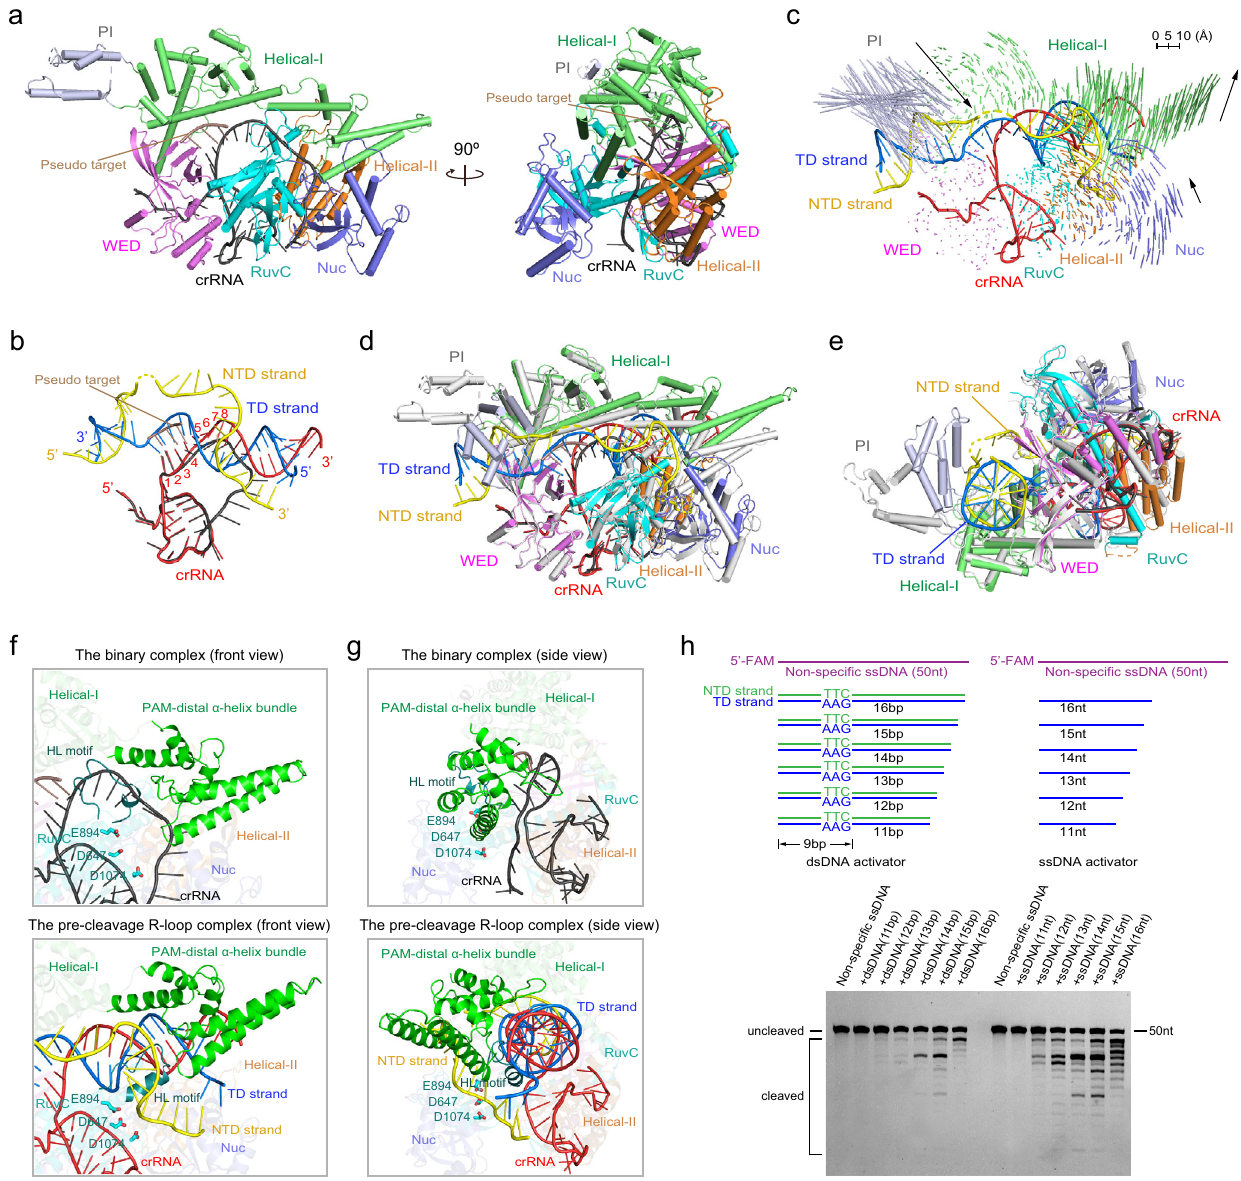
Fig. 6 The target binding triggers the Cas12i1 DNase activity. a Overall structure of the Cas12i1 binary complex shown in two different orientations. b Structural comparison of crRNAs in the Cas12i1 binary and pre-cleavage R-loop complexes. crRNAs are colored as in ( a ) and Fig. 1. c Structural comparison of Cas12i1 in the binary and pre-cleavage R-loop complexes. Vector length correlates with the motion scale of each domain in Cas12i1. Black arrows indicate domain movements upon the target duplex binding. d , e The overlay of the Cas12i1 binary and pre-cleavage R-loop complexes shown in front and side views. Cas12i1 and crRNA in the binary complex are colored in silver and black, and the pre-cleavage R-loop complex is colored as in Fig. 1. Note that the PI and Helical-I domains undergo signi fi cant rearrangements. f Close-up front views of the Cas12i1 binary and pre-cleavage R-loop complexes. The PAM-distal α -helix bundle of the Helical-I domain exhibits an upward movement and the HL motif rearranges its conformation. g Close-up side views of the Cas12i1 binary and pre-cleavage R-loop complexes. A single central channel can be observed in the binary complex to accommodate the crRNA guide region, whereas two channels separated by the HL motif are formed in the pre-cleavage R-loop complex to accommodate the crRNA guide region-TD strand heteroduplex and the NTD strand. h Schematic representations of double-stranded DNA (dsDNA) activators and single-stranded DNA (ssDNA) activators with different lengths. Denaturing gel demonstrating the cleavage of the fl uorescently labeled non-speci fi c ssDNA by wild-type Cas12i1 in complex with crRNA and in the presence of dsDNA or ssDNA activator. The cleavage assays were repeated three times independently to con fi rm the repeatability and source data are provided as a Source data fi